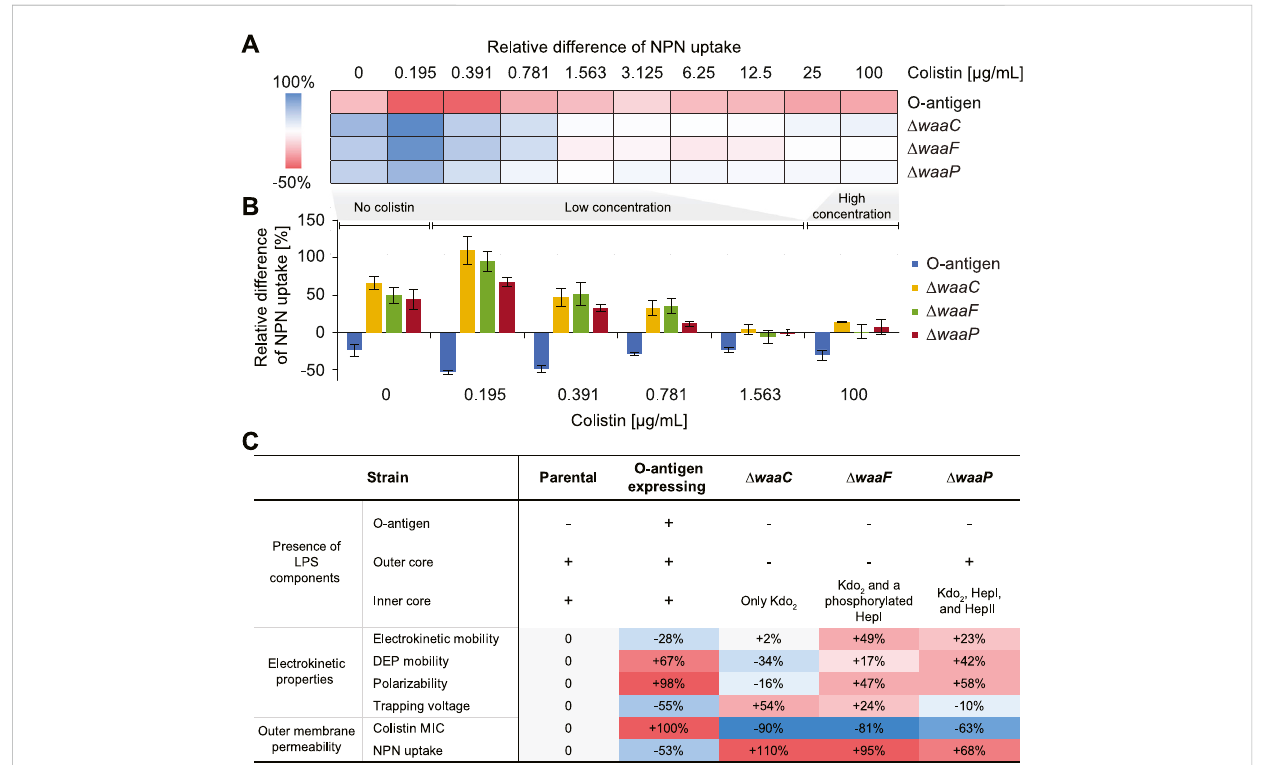
Effectsof E.coli LPSstructuralvariationsoncolistin-mediatedouter-membranedisruption. (A) Aheatmapshowingthemeanrelativedifferencesof N -phenyl-1-naphthylamine (NPN) uptake compared to the parental strain for the E. coli O-antigen expressing strain and mutants with truncated core oligosaccharide (as computed by Eq. 3 in Methods). NPN uptake represents the ratio of background (absence of NPN) subtracted fl uorescence values of the bacterial suspension to that of the suspending medium normalized by the cell abundance (details in Methods). (B) Bar plot showing the relative differences of NPN uptake for the O-antigen expressing strain and LPS core mutants at low (0 – 1.563 μ g/mL) and high (100 μ g/mL) colistin concentrations.ThezerolinecorrespondstotheNPNuptakeleveloftheparentalstrain. Errorbarsindicatestandarderrorsofthreereplicates. (C) Atable comparing expressed LPS components, electrokinetic properties, and outer membrane permeability of each strain. The ‘ + ’ / ‘–’ signs indicate the presence/absence of a corresponding LPS component. Percentages indicate the deviation of mean values relative to that of the parental